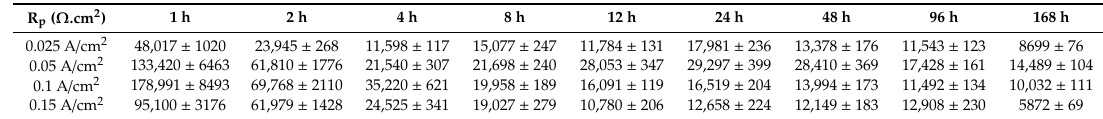
Figure 10. Nyquist diagrams of PEO coatings prepared in the electrolyte with 12 g / L Na 3 PO 4 with different applied current densities after 1 h ( a ) and 168 h ( b ). Table 10. Values of R p of PEO coatings prepared in the electrolyte with 12 g / L Na 3 PO 4 with various applied current densities measured in 0.1 M